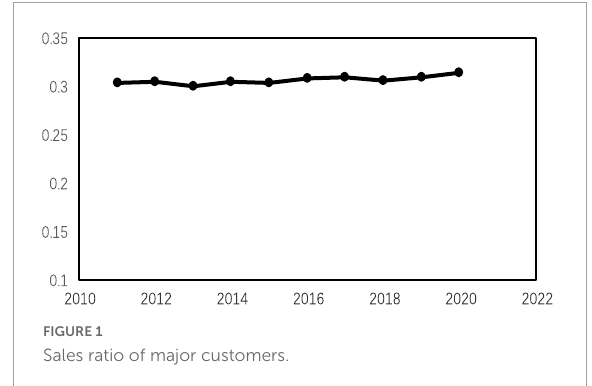
FIGURE1 Sales ratio of major